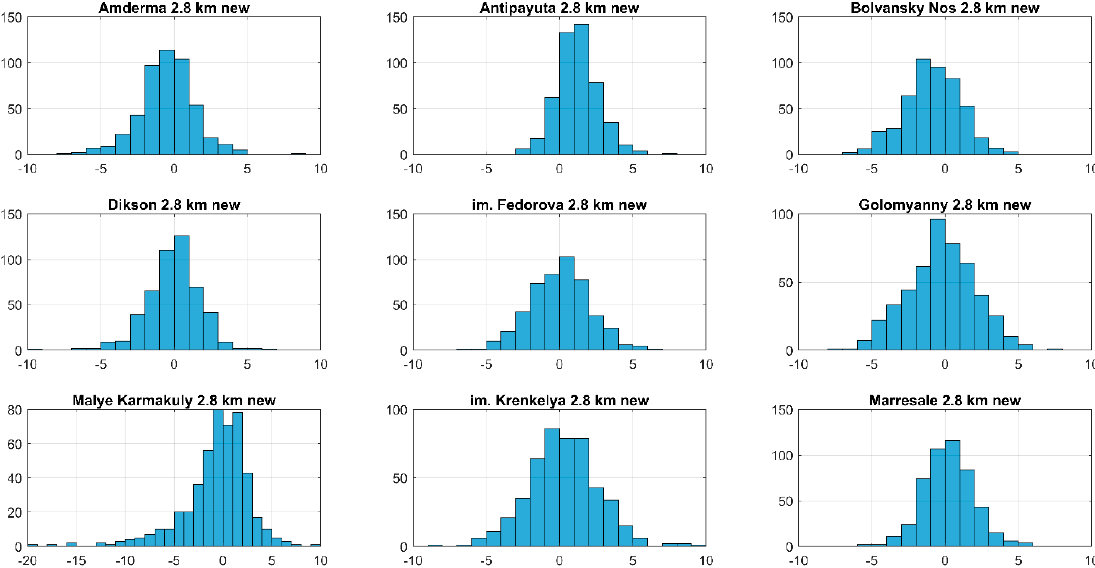
Figure 3. Probability distribution functions of errors at the several stations for the 2012 period experiment “2.8 km _sn”.